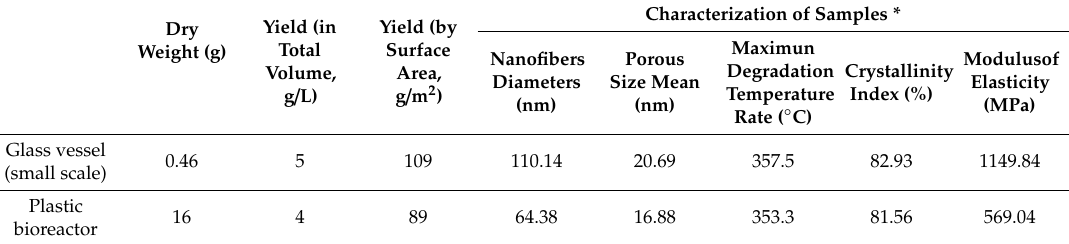
Table 5. Comparison of the BNC yield obtained in the glass vessels and plastic bioreactor. The reduction in BNC yield is notable. However, these results were expected because is not possible to obtain the same results in both scales.